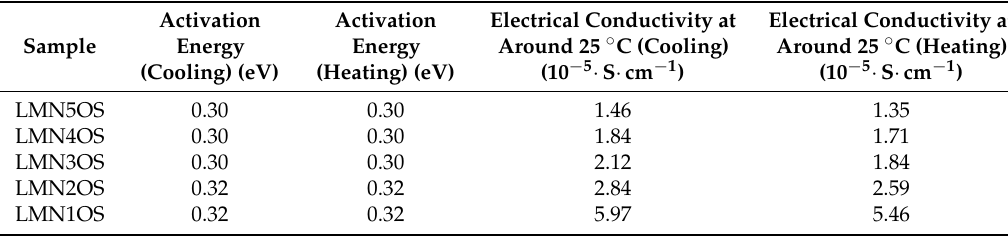
Table 2. Electrical properties of the synthesized spinels.